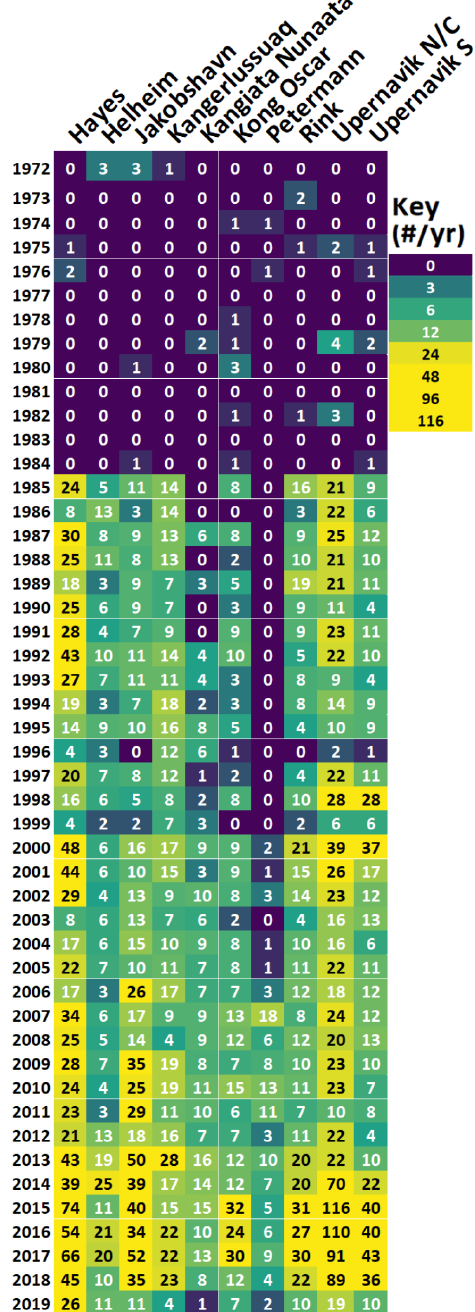
Figure 2. Temporal coverage map. Number of fronts per year from 1972–2019 for 10 high discharge volume basins. For the full tem- poral coverage map, see Supplement Fig.